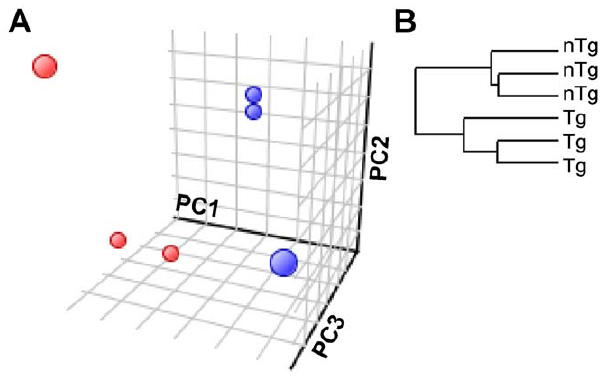
Figure 3. Transcriptional Profiles of B.theta Recovered from the Ceca of Monoassociated Rats. (A) 3-dimensional principal compo- nents analysis and (B) unsupervised hierarchical clustering of tran- scriptomes of cecal B. theta from 6-week monoassociated rats (PC1=36.1%, PC2=23.9%, PC3=21.7%). Red and blue spheres repre- sent bacterial transcriptomes from HLA-B27 transgenic (Tg) and non- transgenic (nTg) rats, respectively.